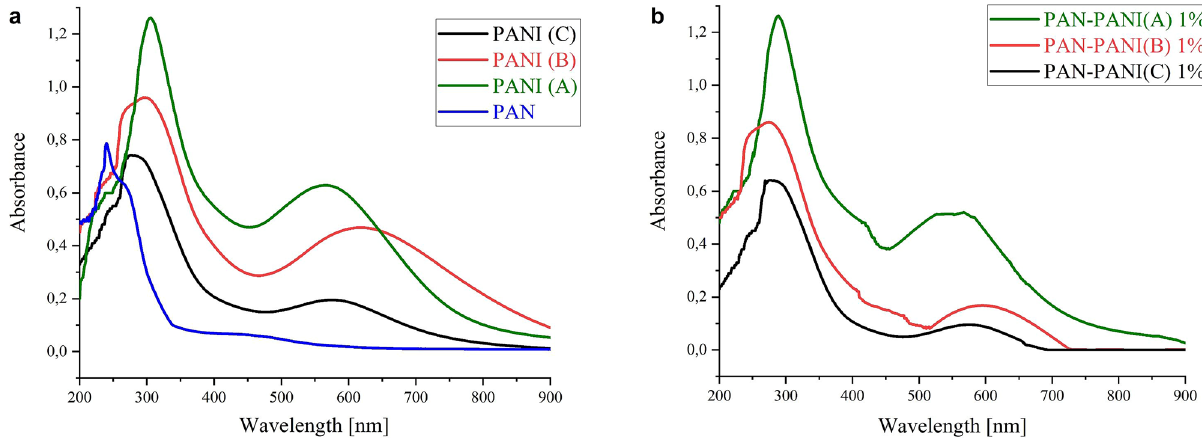
Figure 3. UV–Vis spectra of ( a ) synthesized polyanilines (A, B, C), polyacrylonitrile and ( b ) composites produced from polyanilines with